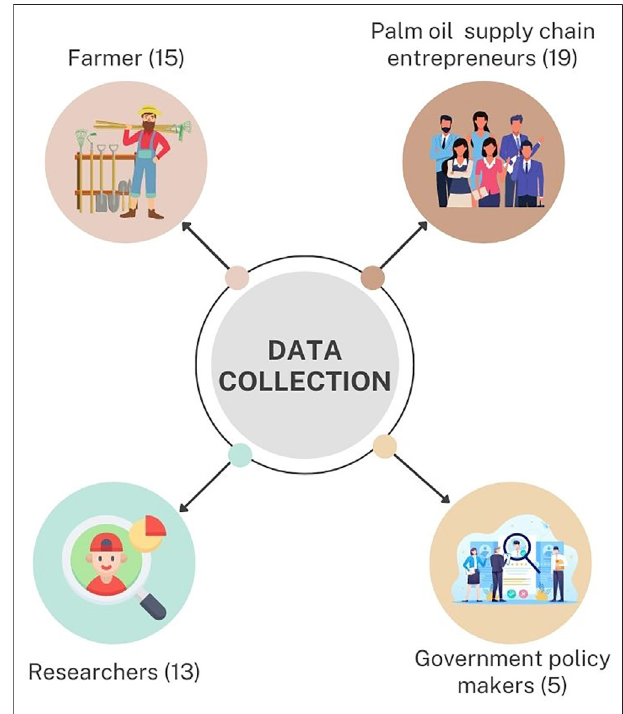
FIGURE 1 | Sample sizes in each group of